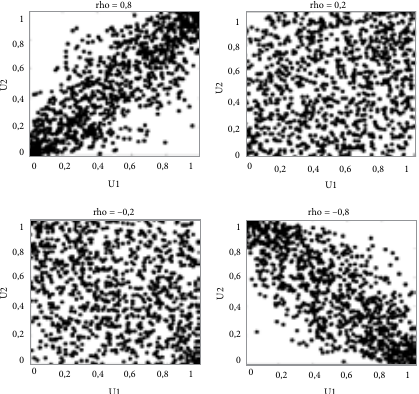
Fig. 3. Gaussian dependency structures with different correlation